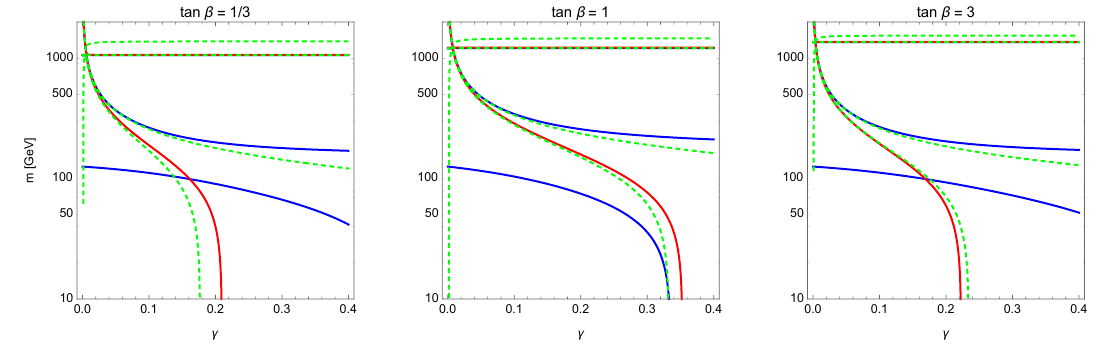
Figure 5 . Spectra for (cid:28) = 0 : 1, C t = 2 and C g = 1 = 3 C t . The blue, green and red lines correspond to neutral scalars, pseudo-scalars and charged scalars respectively. We (cid:12)x K (cid:14) = 0 : 3 and show spectra for tan (cid:12) = 1 = 3, 1 and 3.